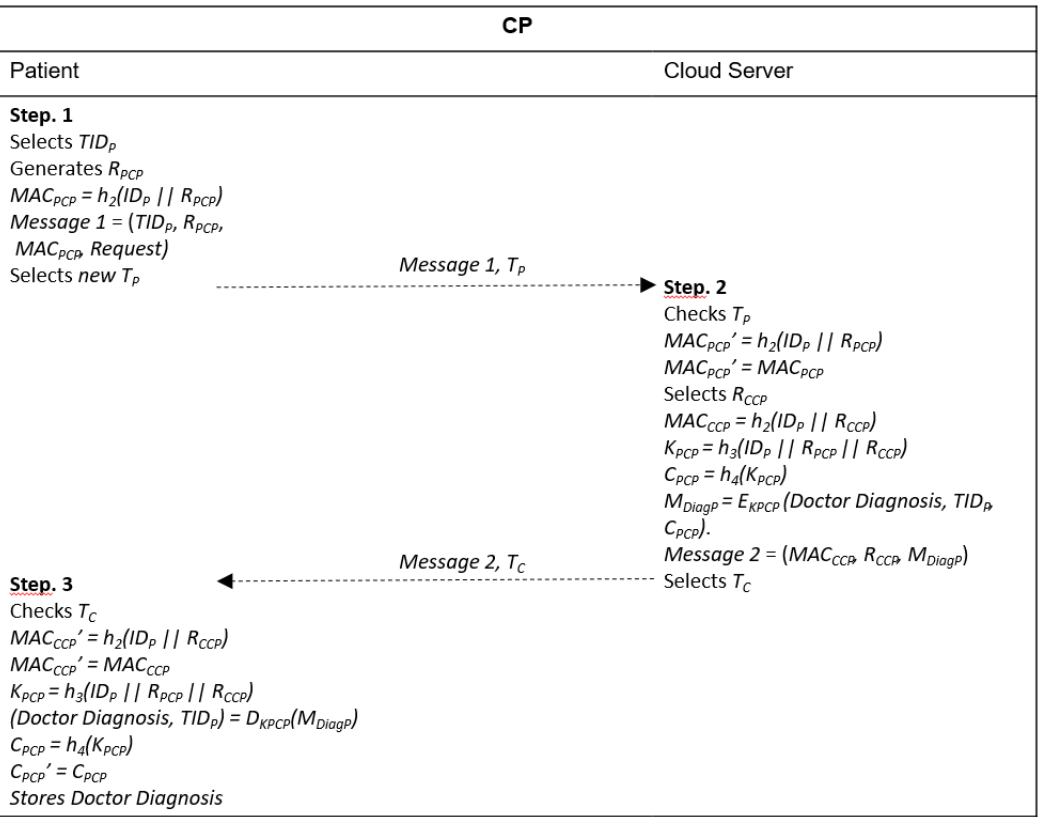
Figure 6. Message exchange in checkup phase (CP).